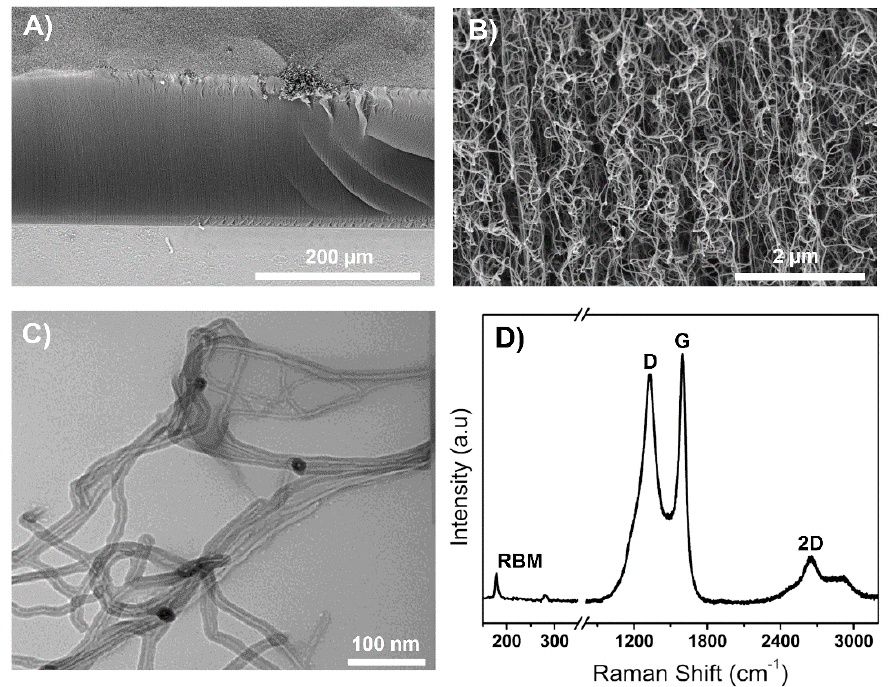
Figure 6. Characterization of VA-CNTs grown from the premade nanoparticle monolayer assembly. ( A ) Low-magnification SEM image, ( B ) high-magnification SEM image, ( C ) high-magnification TEM image, and ( D ) Raman spectrum of VA-CNTs.